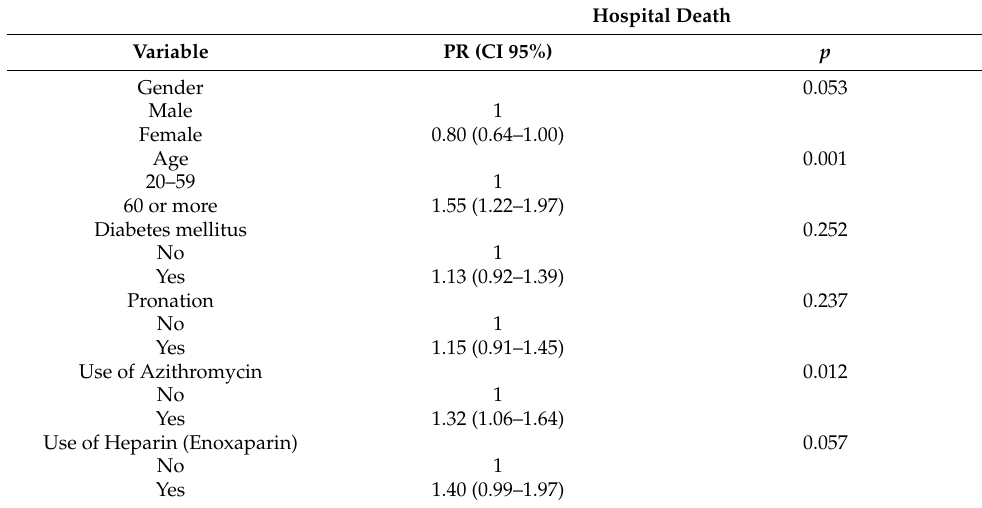
Table 2. Multiple regression analysis of the association of in-hospital death and sociodemographic data, chronic diseases, and treatment in patients with severe acute respiratory syndrome due to COVID-19 ( n =